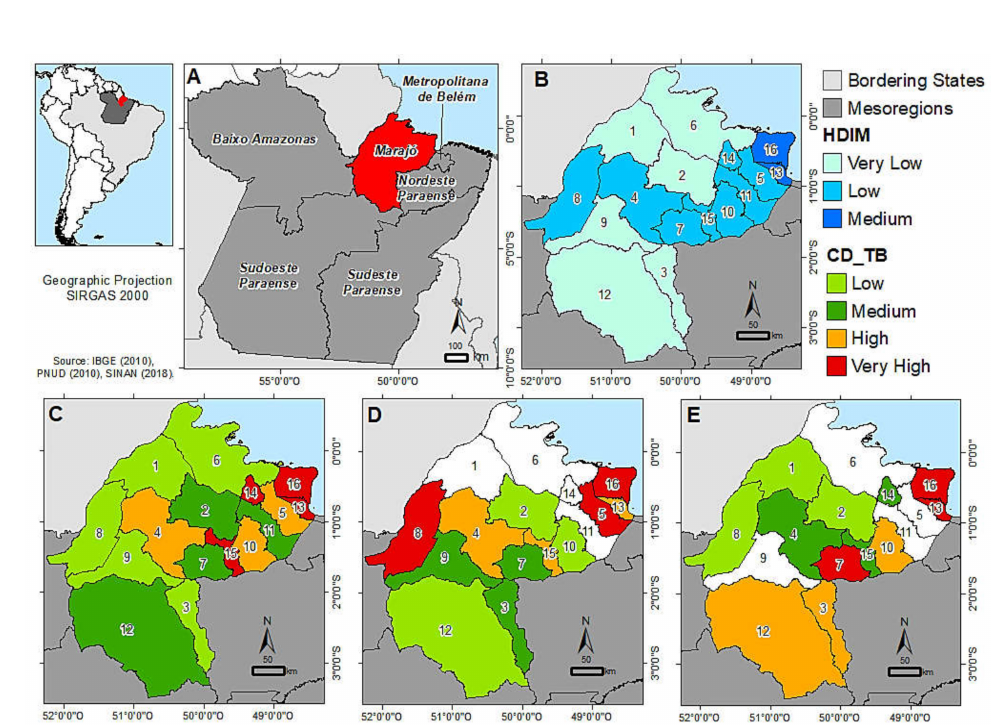
Figure 2. ( A ) Mesoregions of Par á ; ( B ) Municipal Human Development Index (HDIM); ( C ) new cases; ( D ) relapse; and ( E ) re-admission of tuberculosis cases by the